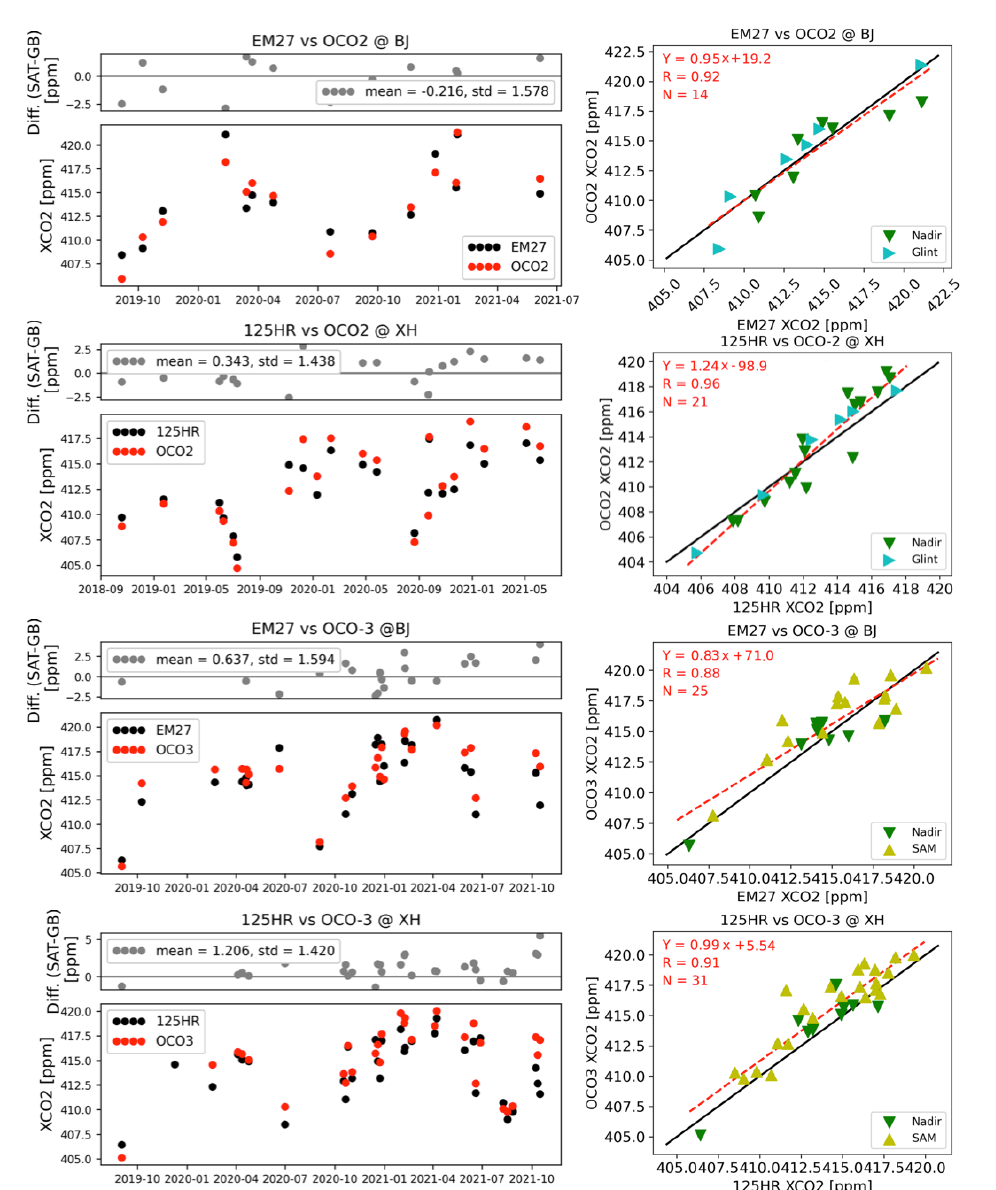
Figure 8. The time series and correlation plots of the co-located FTIR and OCO-2/3 satellite measure- ments. From top to bottom: EM27/SUN against OCO-2 in Beijing; 125HR against OCO-2 in Xianghe, EM27/SUN against OCO-3 in Beijing; and 125HR against OCO-3 in Xianghe. OCO-2 provides nadir and glint measurements, and OCO-3 provides nadir and snapshot area mode (SAM) measurements over Beijing and